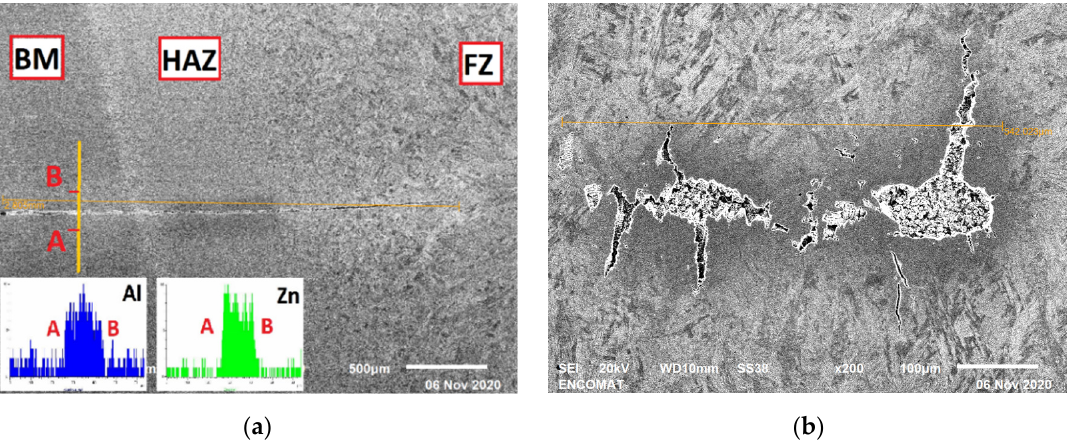
Figure 6. SEM of D min for f = 1000 Hz: ( a ) the nterface; ( b ) detail of the central defect in the FZ.